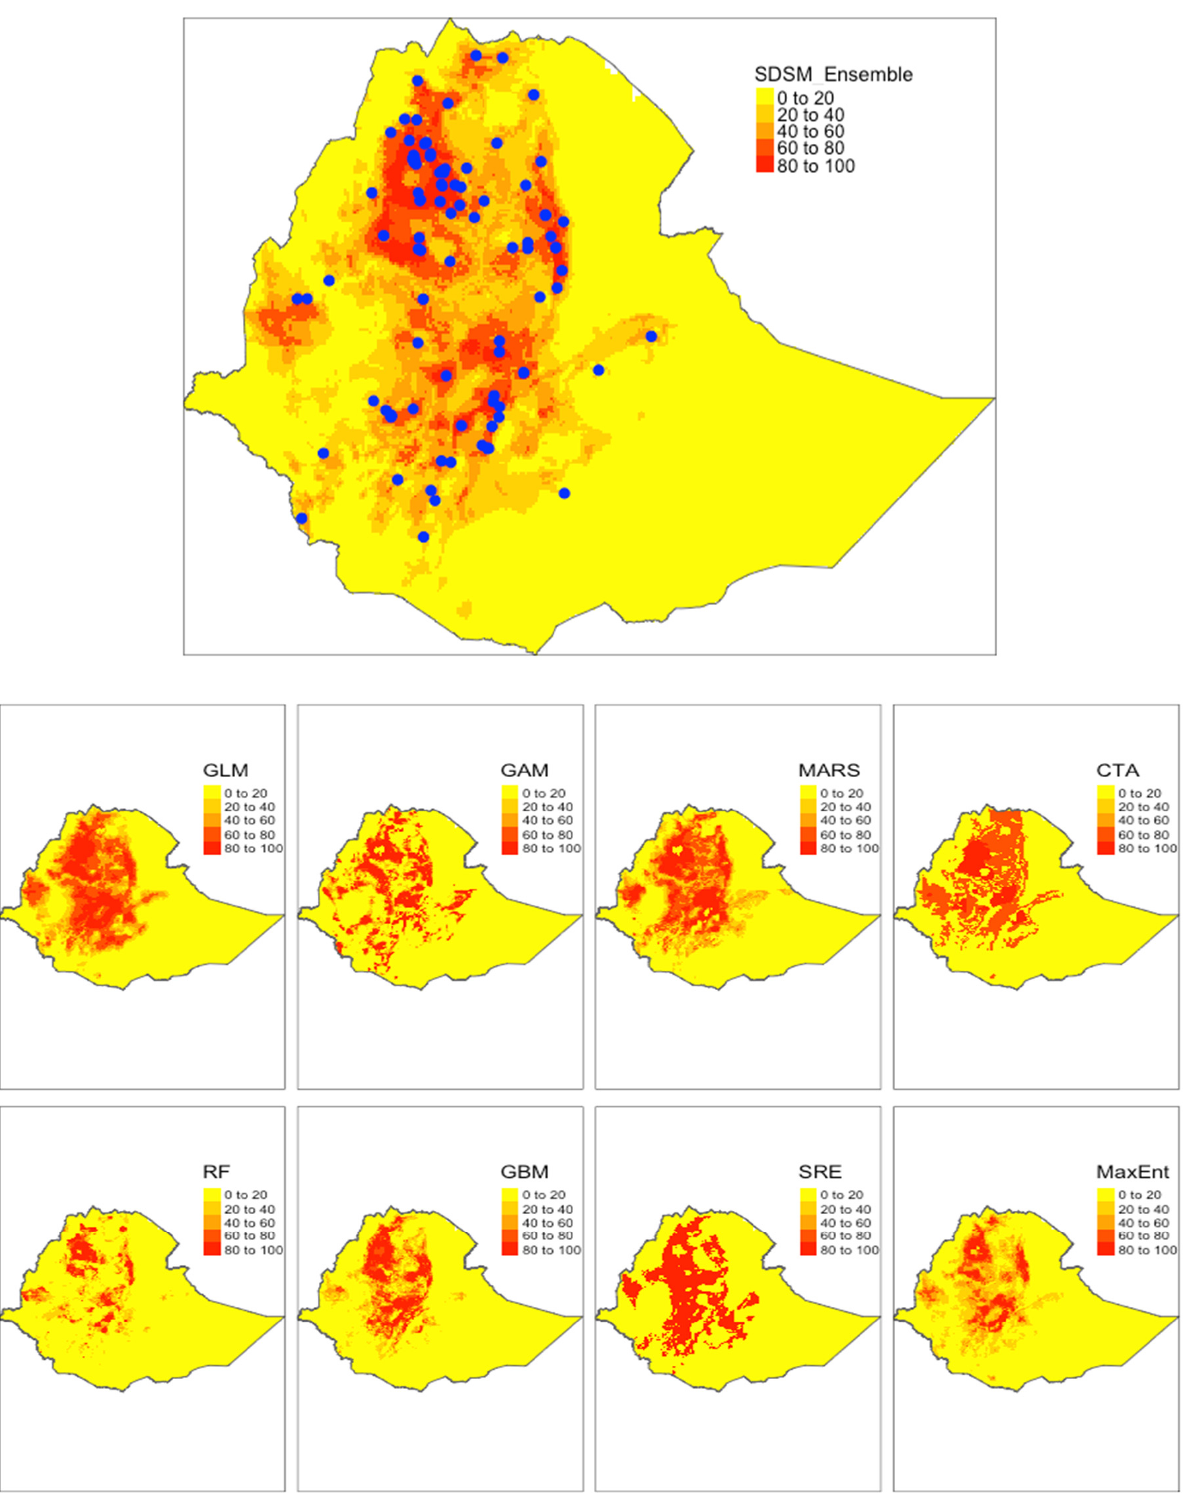
Figure 4. SDSM-based results showing potential distribution of S. mansoni endemic areas in Ethiopia from different models. Blue dots represent the occurrence locations. Legend shows a probability of occurrence given the environmental suitability ranging from 0 to 100 percent.